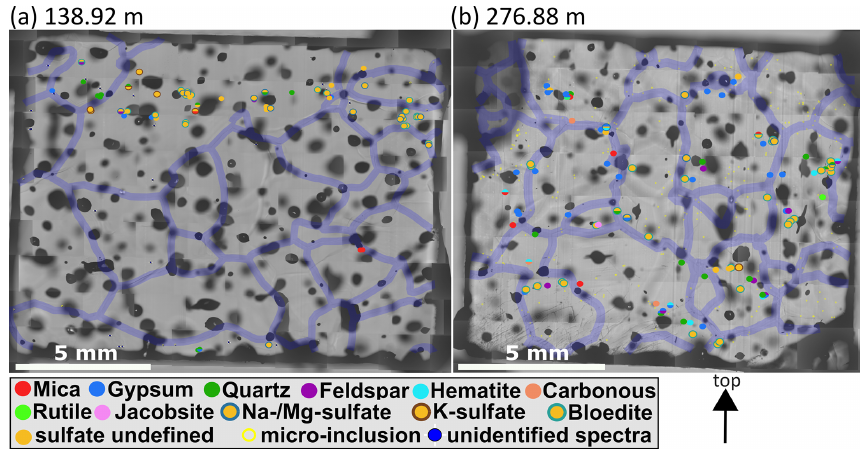
Figure 7. Impurity maps of S1 (138.92m) and S2 (276.88m). Identified micro-inclusions are represented by filled circles with different colours; sulfates are orange circles with differently coloured contours. Transparent violet lines are 300µm thick grain boundaries, and the arrow points towards the surface of the ice sheet. (a) A layer of sulfate micro-inclusions is in the upper part of the sample, and below are almost no micro-inclusions. (b) A wide variety of different Raman spectra and spatial patterns, e.g, clusters and rows of sulfates.